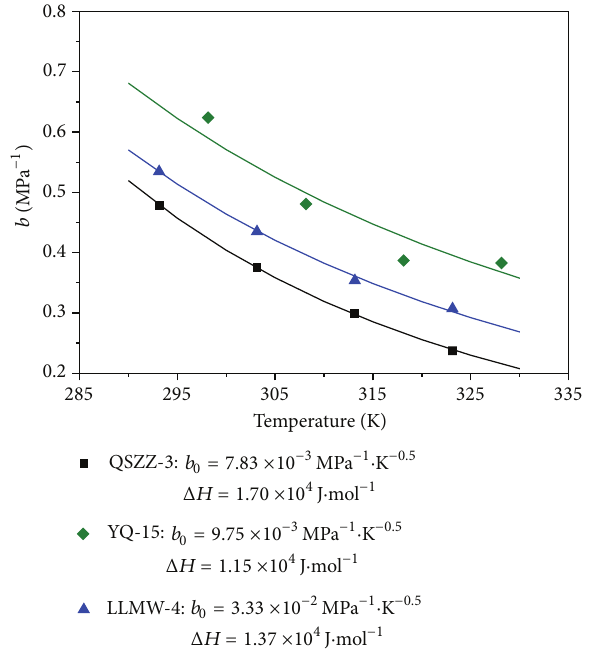
Figure 2: Relationship between the adsorption parameter and